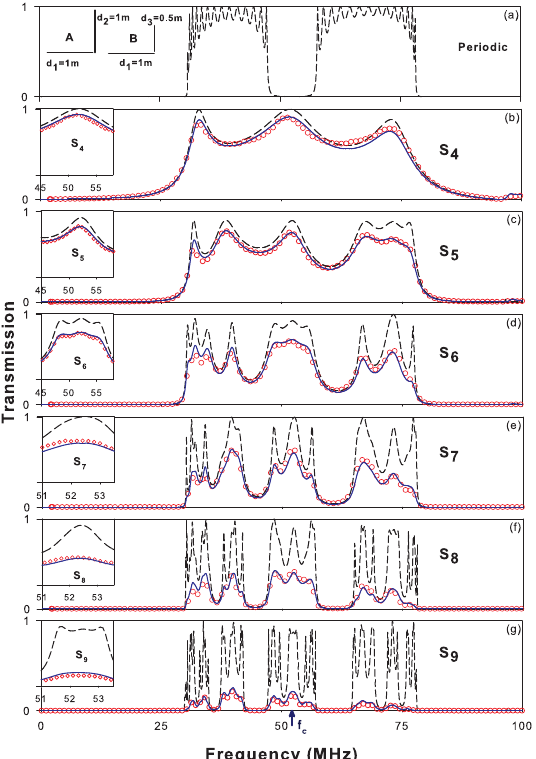
Figure 3. Theoretical (solid lines) and experimental (open circles) evolution of the transmission coefficients versus the frequency for different structures. The dashed curves in ( a – g ) are the theoretical curves when the absorption is not taken into account. The inset of ( a ) corresponds to the schematic illustration of blocks A and B constituting the systems. ( a ) The periodic structure, ( b – g ) generation S k ( k = 4–9) of the Fibonacci structure. One can compare the scale of the frequency axis near the central frequency f c in the insets of the figures associated with the generations S 4 , S 5 , S 6 and those of S 7 , S 8 , S 9